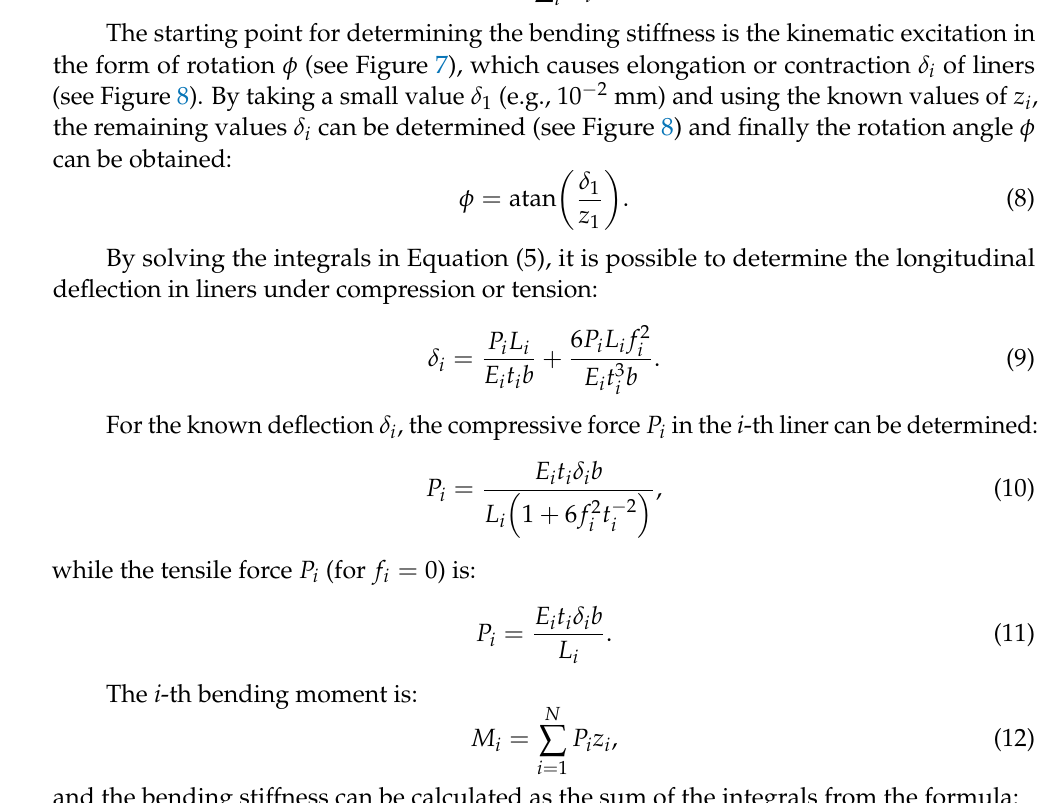
Figure 8. Corrugated board bending–compressing the layer of higher fluting.